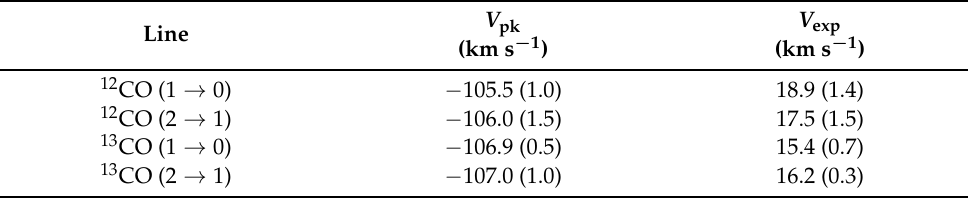
Table 1. Parameters of the 12 CO and 13 CO line emission in IRAS 17393 − 2727.